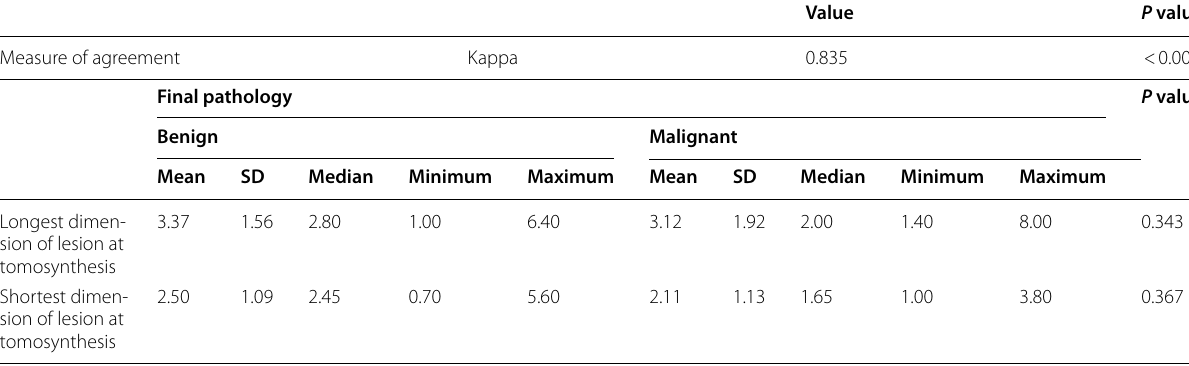
Table 11 Correlation between lesion size and pathology at tomosynthesis